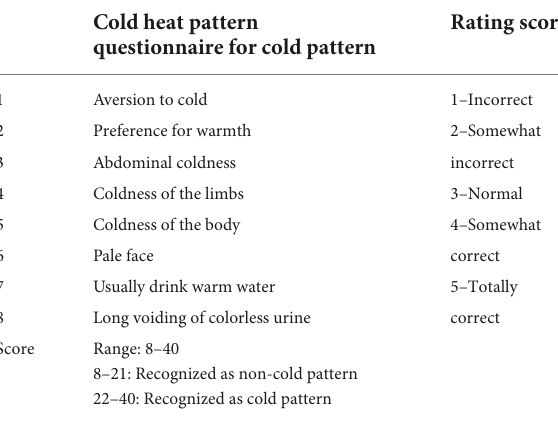
TABLE 1 Description of the cold heat pattern questionnaire for cold pattern which was used in this